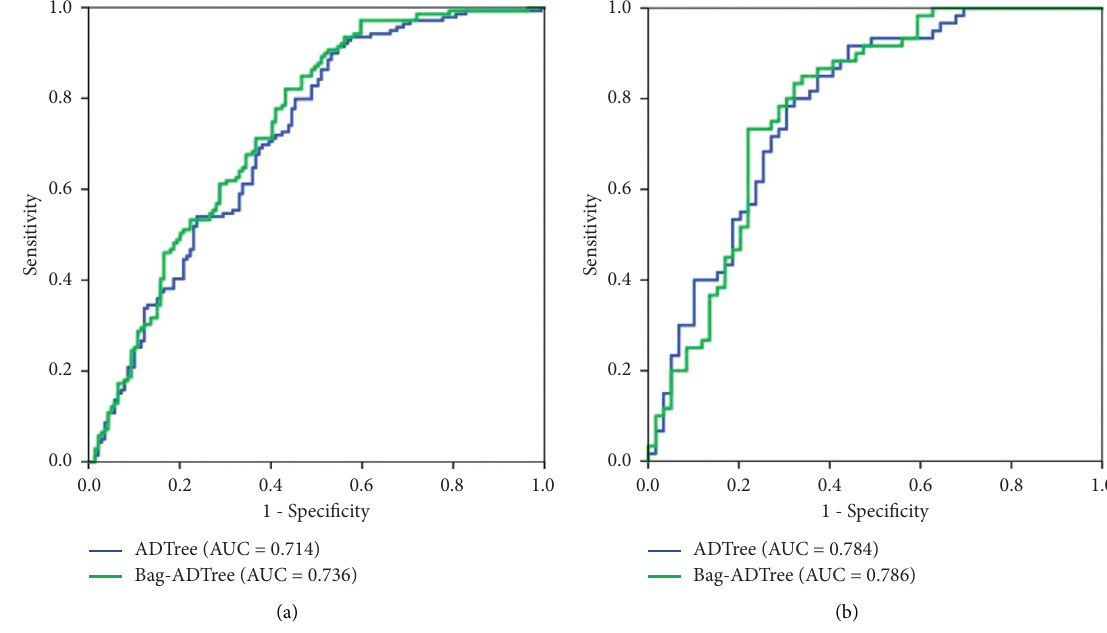
Figure 18: The success and prediction rate curves for flooding map. (a) Success rate and (b) prediction